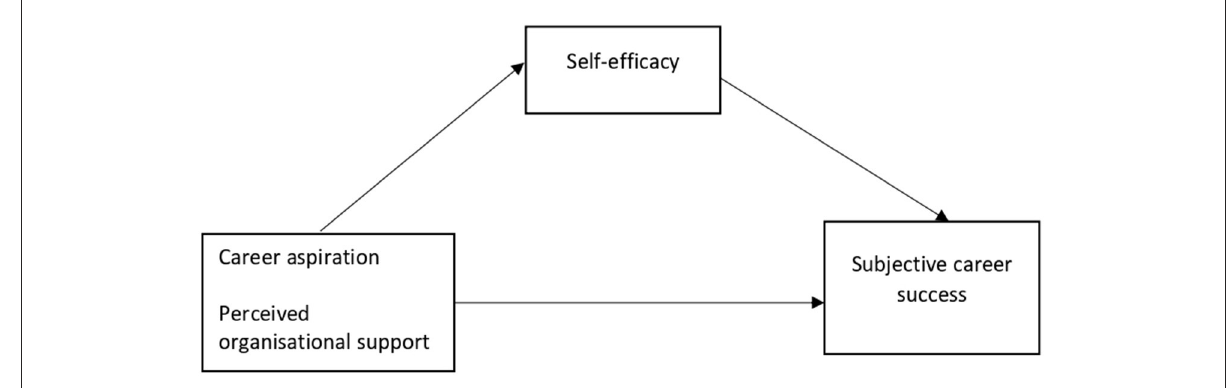
FIGURE1 Framework of the study showing the independent variables, the mediator, and the dependent